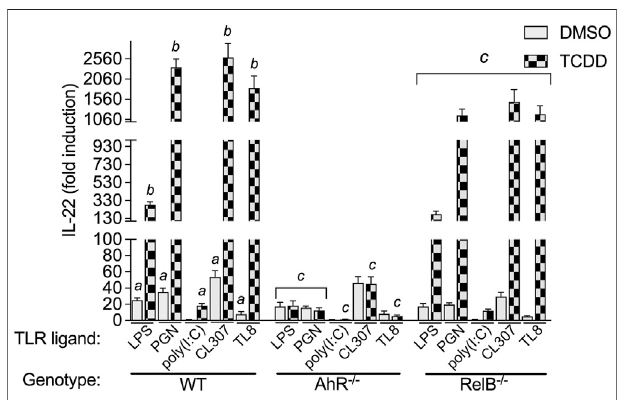
FIGURE 3 | Effect of TLR ligands on IL-22 mRNA expression in macrophages.BMMderivedfromWT,AhR − / − ,andRelB − / − miceweretreated with LPS (1.0 μ g/ml), PGN (1.0 μ g/ml), poly(I:C) (1.0 μ g/ml), and CL307 (1.0 μ g/ml),innon-treatedandTCDD-(1